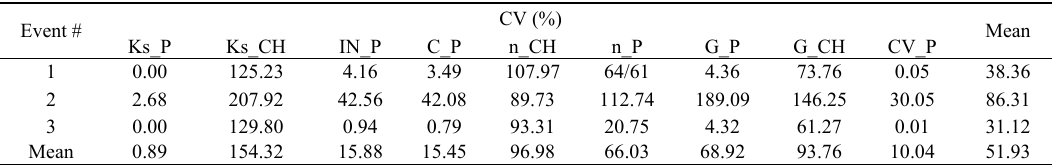
Table 4: Coefficient of variations (CV) in peak discharge in accordance with the alterations in K2 parameters